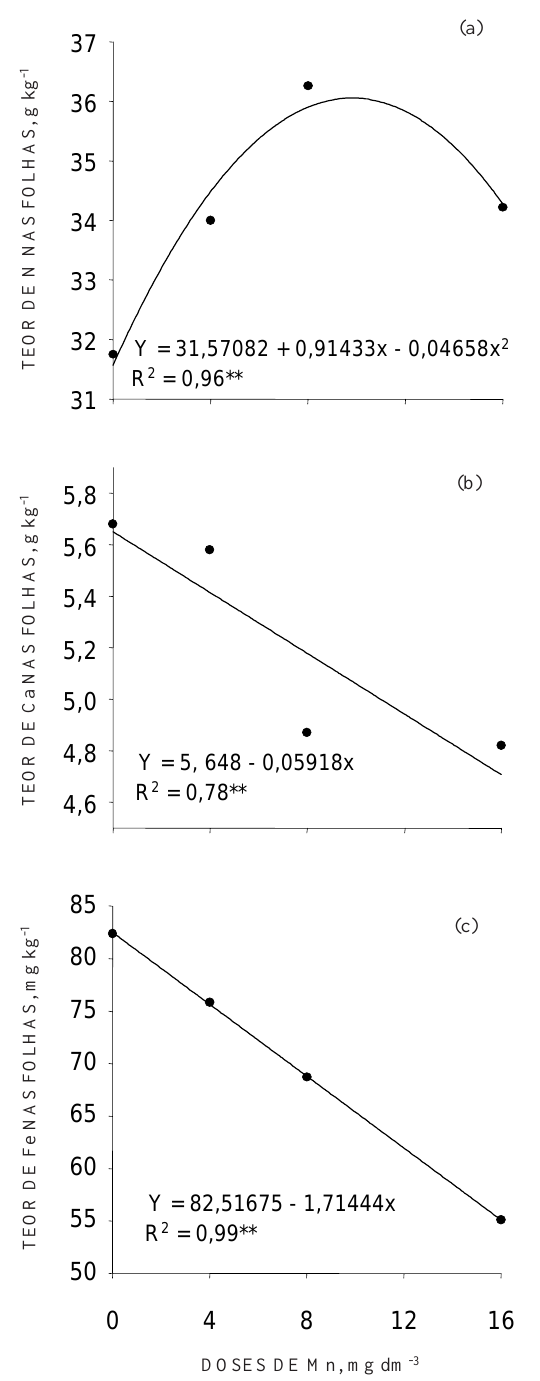
Figura 3. Teores foliares de N (a), Ca (b) e Fe (c) para ambos os cultivares estudados, considerando as doses de manganês aplicadas ao